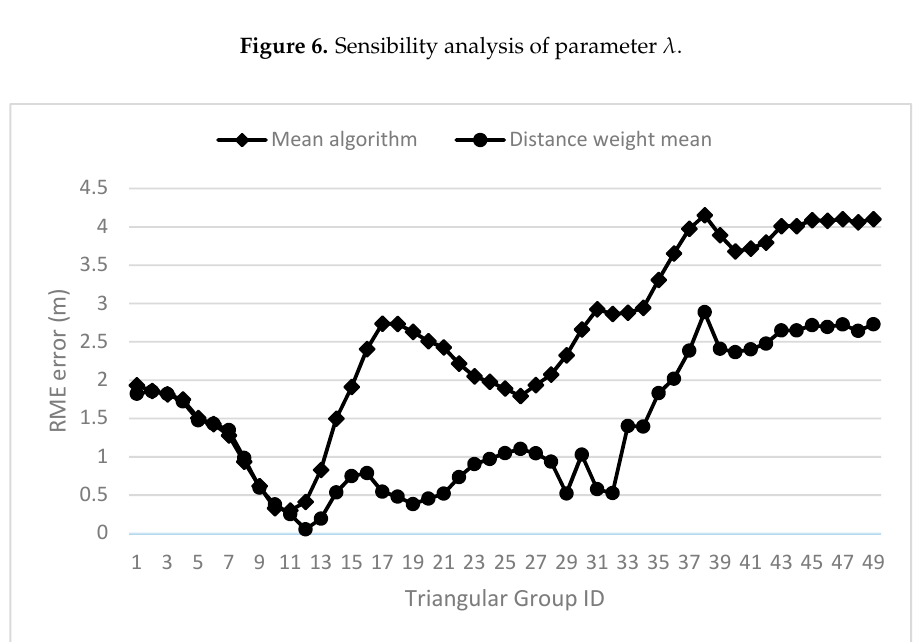
Figure 7. Comparison of algebraic mean algorithm and distance weight mean algorithm.